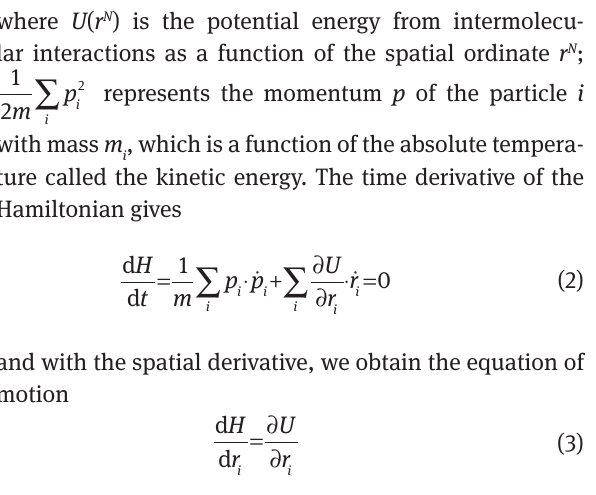
) experienced by αβ